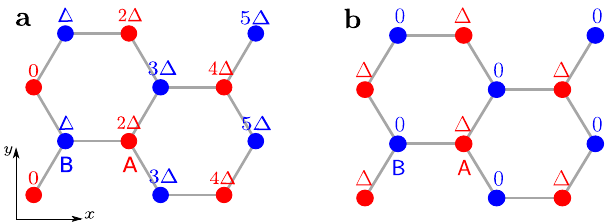
Fig. 12 Floquet engineering strain schemes. Two possible Floquet engineering schemes of strain as described in the main text. a Energy offset Δ linearly growing in the x direction. b Homogeneous energy offsets Δ only on the